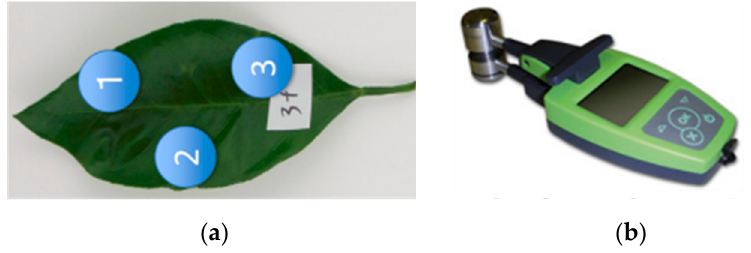
Figure 5. Fluorescent sensor used and measuring area of the leaf: ( a ) Fluorescent sensor used in this study; ( b ) Measurement areas in each leaf.